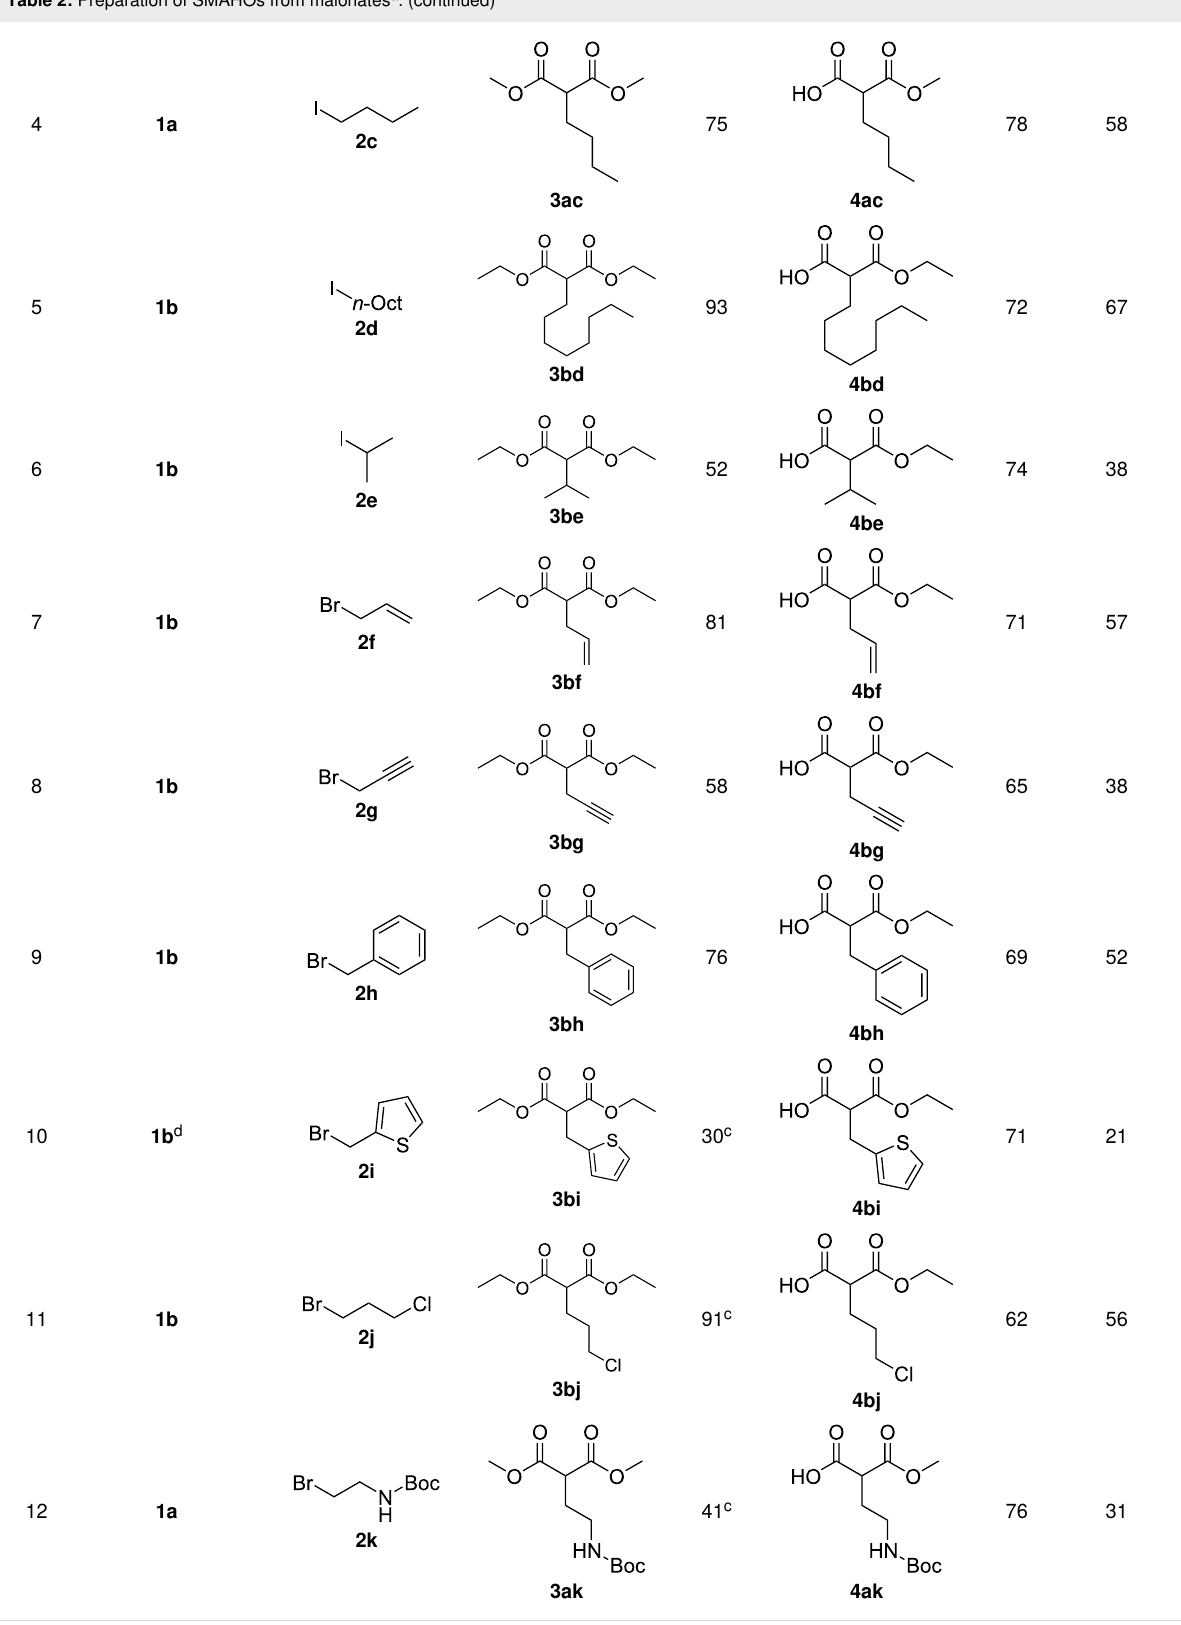
Table 2: Preparation of SMAHOs from malonates a .